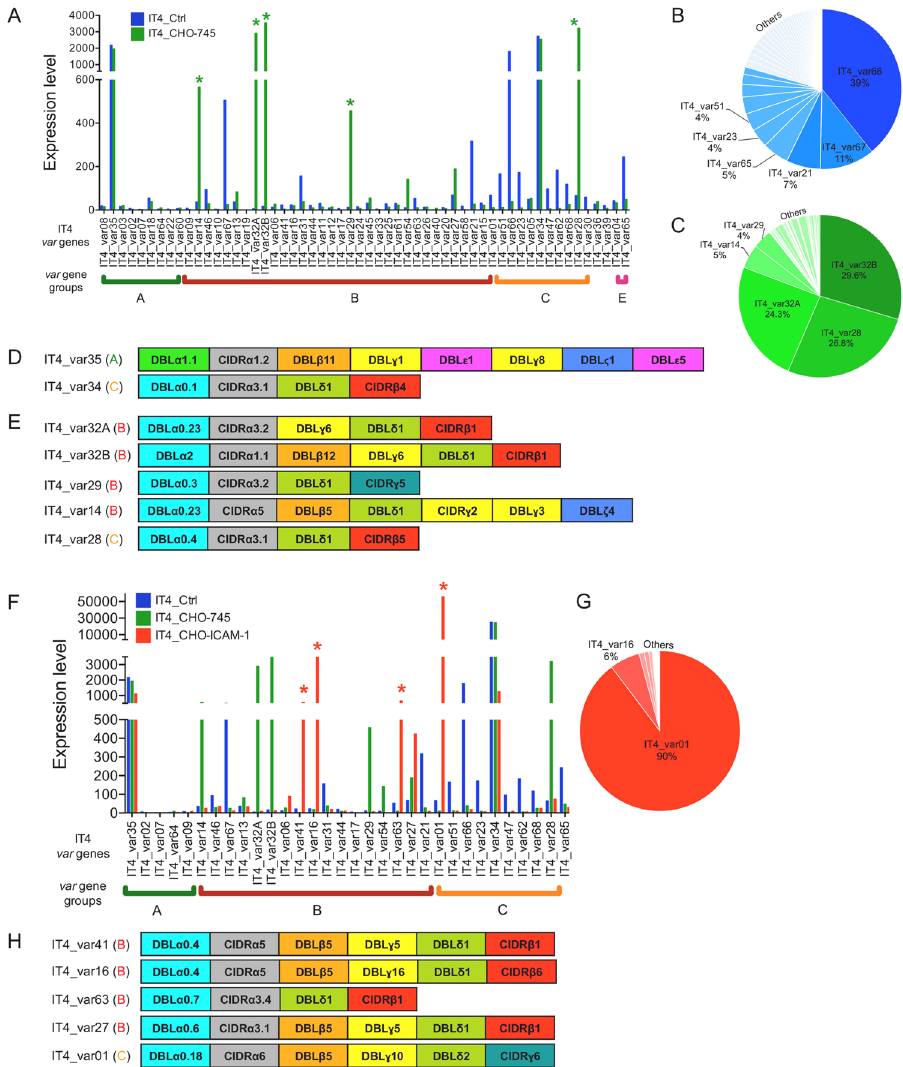
Figure 2. Enrichment of a P. falciparum IT4 population for parasites binding to CHO-745 WT cells (IT4_ CHO-745) and for ICAM-1–binding parasites (IT4_CHO-745–ICAM-1). ( A ) The expression of a selected set of var genes in long-term cultured IT4 parasites (IT4_Crtl) and IT4_CHO-745 (expression level is defined as average of the normalized read counts). var genes with a significantly higher expression in IT4_CHO-745 than in IT4_Ctrl are marked by green stars (padj < 0.05). ( B ) Distribution of var gene expression in the IT4_Crtl population. ( C ) Distribution of var gene expression in the IT4_CHO-745 population. IT4_var34 and IT4_var35 were excluded from the analyses. ( D ) Schematic representation of Pf EMP1 proteins encoded by IT4_var35 and IT4_var34 genes with high expression levels in all the investigated parasite populations. ( E ) Schematic representation of Pf EMP1 proteins encoded by var genes whose expression was significantly increased in IT4_CHO-745 parasites. ( F ) The expression of a selected set of var genes in IT4_CHO-745–ICAM-1 parasites compared with gene expression in long-term cultured IT4 parasites (IT4_Crtl) and an IT4 population enriched for parasites binding to CHO-745 cells (IT4_CHO-745). var genes with significantly increased expression in IT4_CHO-745–ICAM-1 parasites are marked by red stars (padj < 0.05). ( G ) Distribution of var gene expression in the IT4_CHO-745–ICAM-1 population. IT4_var34 and IT4_var35 were excluded from the analyses. ( H ) Schematic representation of Pf EMP1 proteins encoded by IT4_var41, IT4_var16, IT4_var63, IT4_var01 and IT4_var27 genes whose expression was increased in IT4_CHO-745–ICAM-1 in comparison with IT4_Crtl and IT4_CHO-745